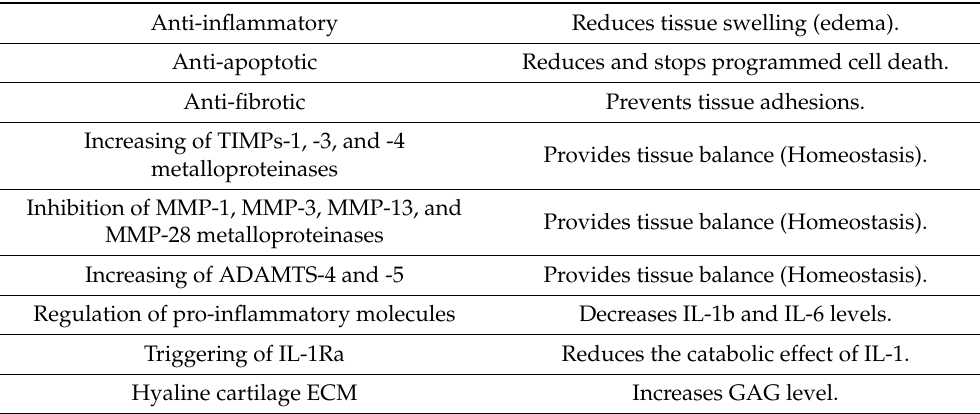
Table 2. Effect of Stromal Vascular Fraction on Tissues.